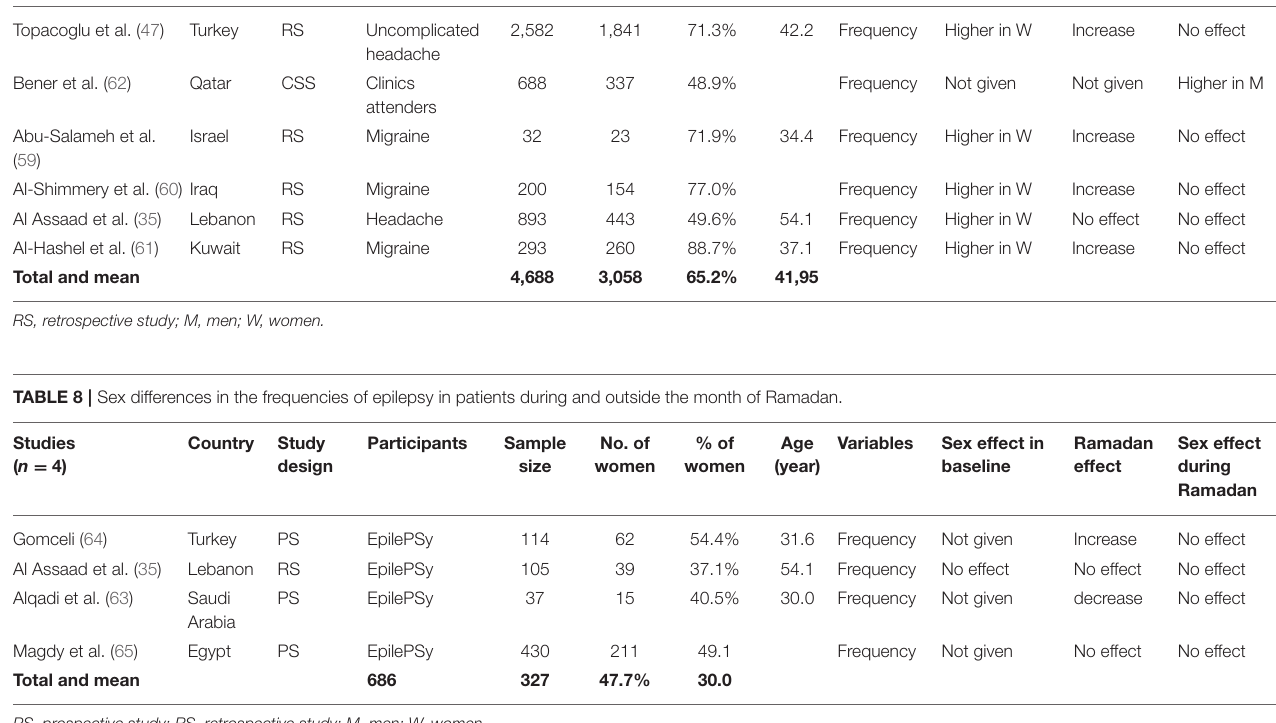
TABLE 7 | Sex differences in the frequencies of Headache in patients during and outside the month of Ramadan. Studies ( n = 6)